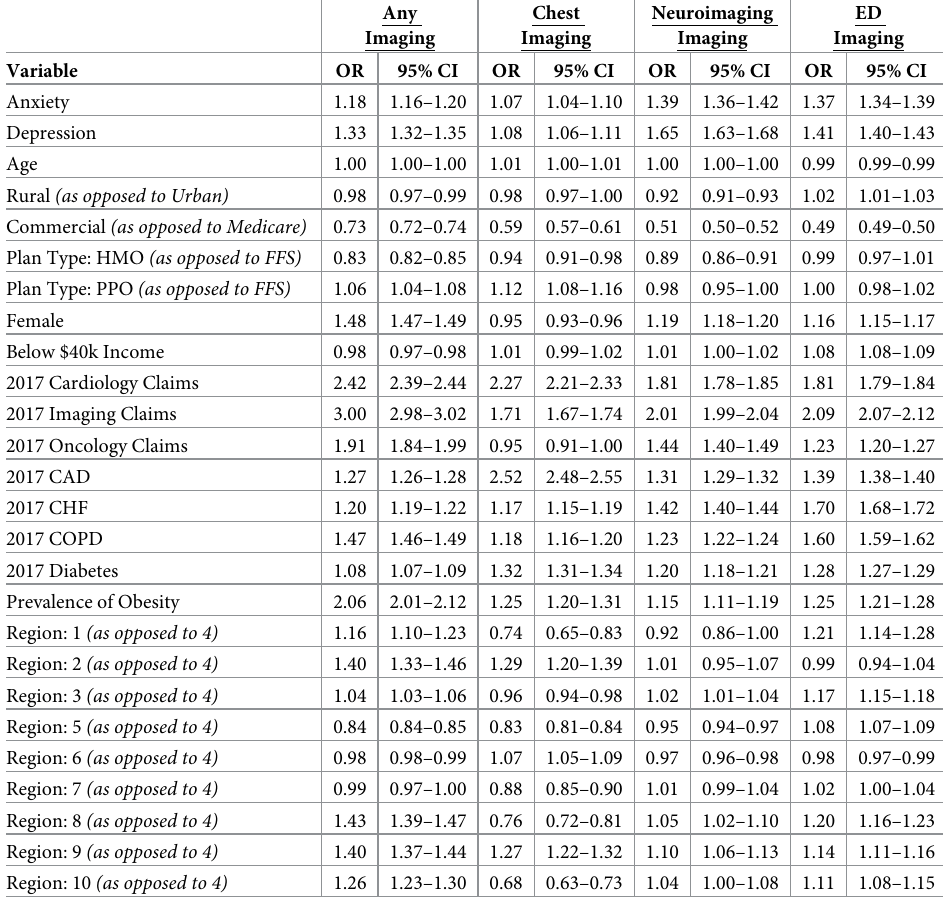
Table 5. Adjusted odds ratios for factors influencing use of any imaging (sample after